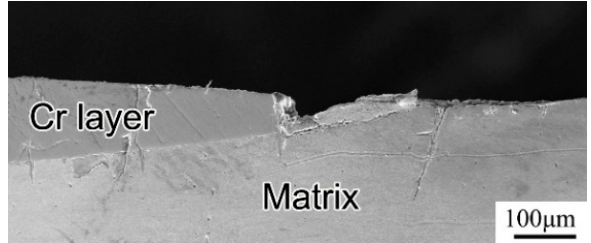
Figure 7. Cross-sectional SEM morphology of MG7.